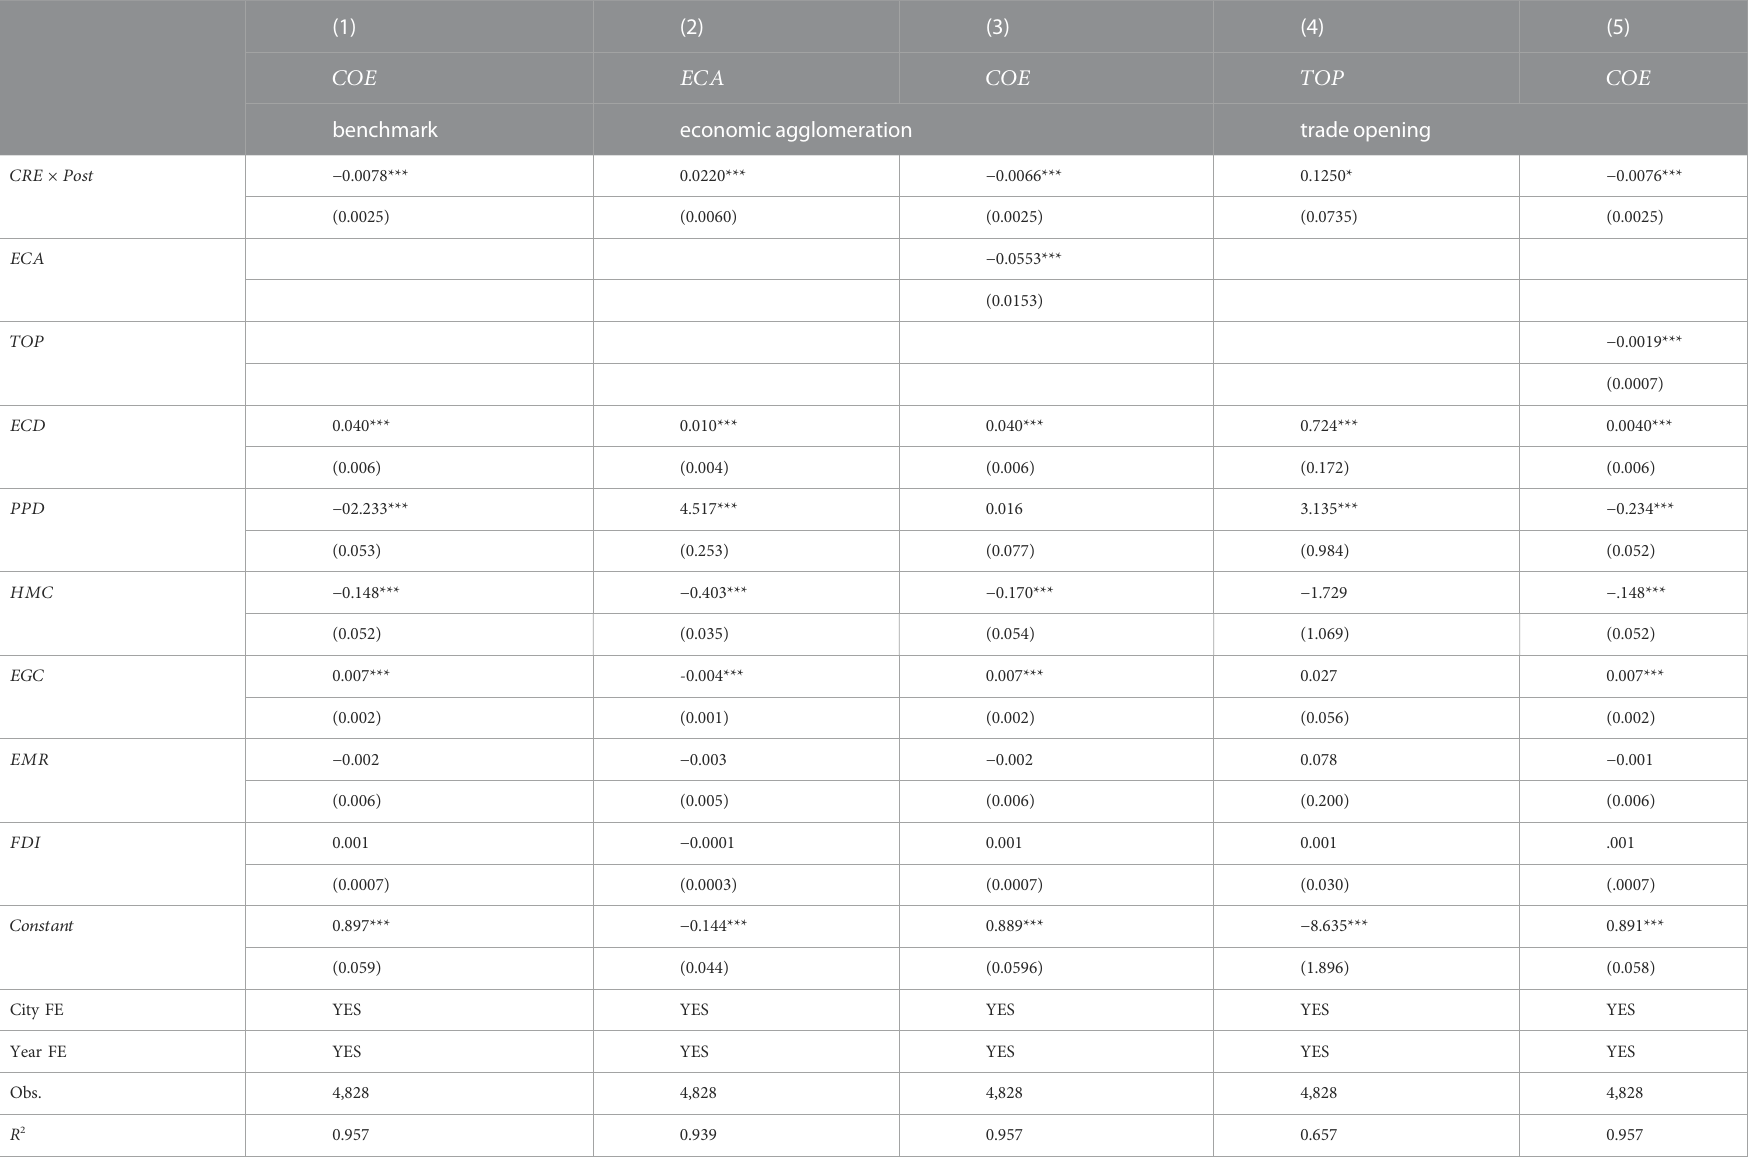
TABLE 6 The result of mechanism analysis: economic agglomeration and trade